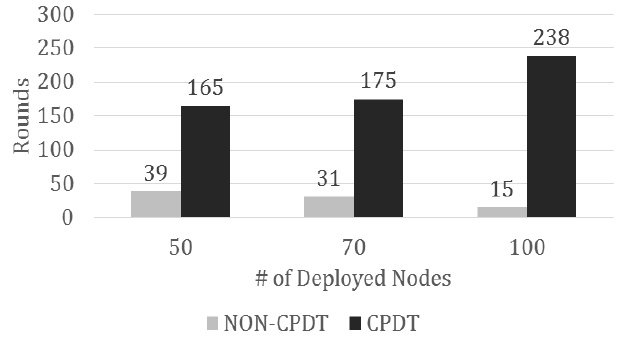
Figure 7. Dead round of the last node.